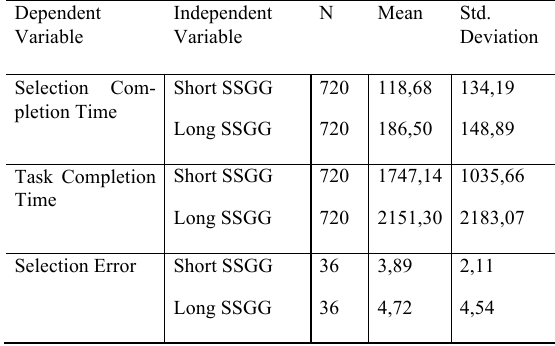
Descriptive statistics for Long and Short